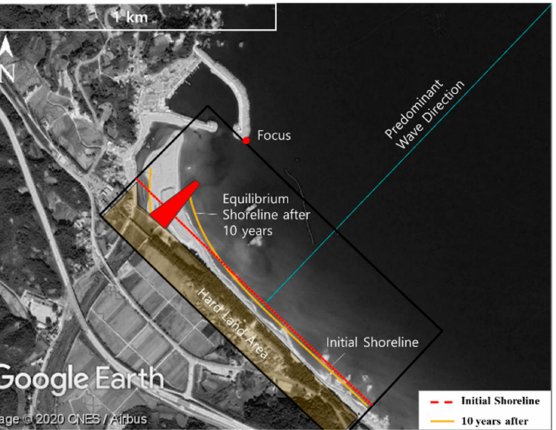
Figure 17. Results of model simulation to reduce erosion of Wonpyeong beach by repositioning groin (image from Google Earth as at October